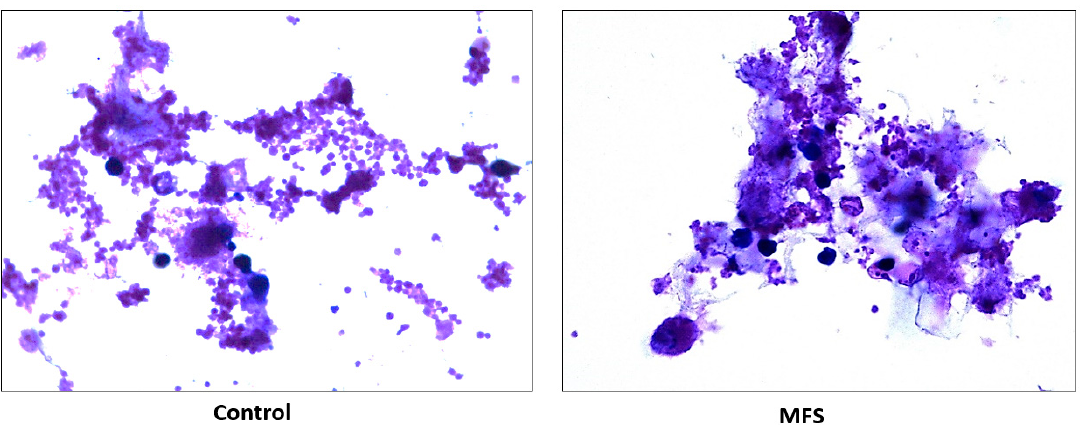
Figure 12. Hematoxylin and Eosin staining of untreated and MFS-treated human granulomas from individuals with T2DM. Microscopy work was done with a light microscope at 100 × magnification under oil